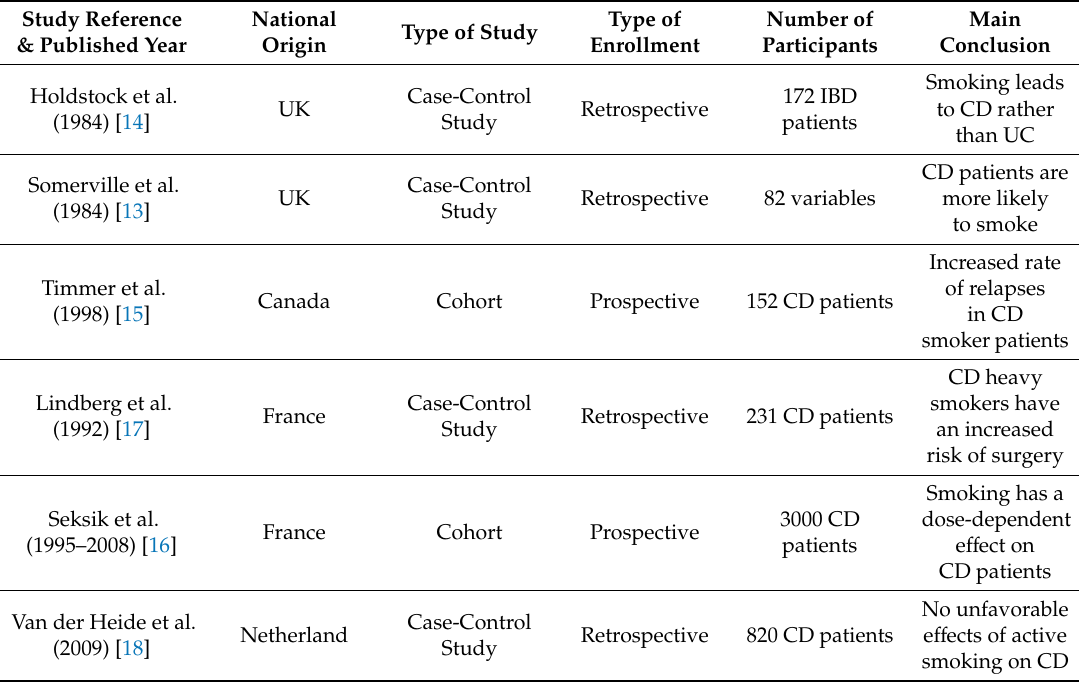
Table 1. List of clinical studies investigating the e ff ect of tobacco smoking on CD patients. Study